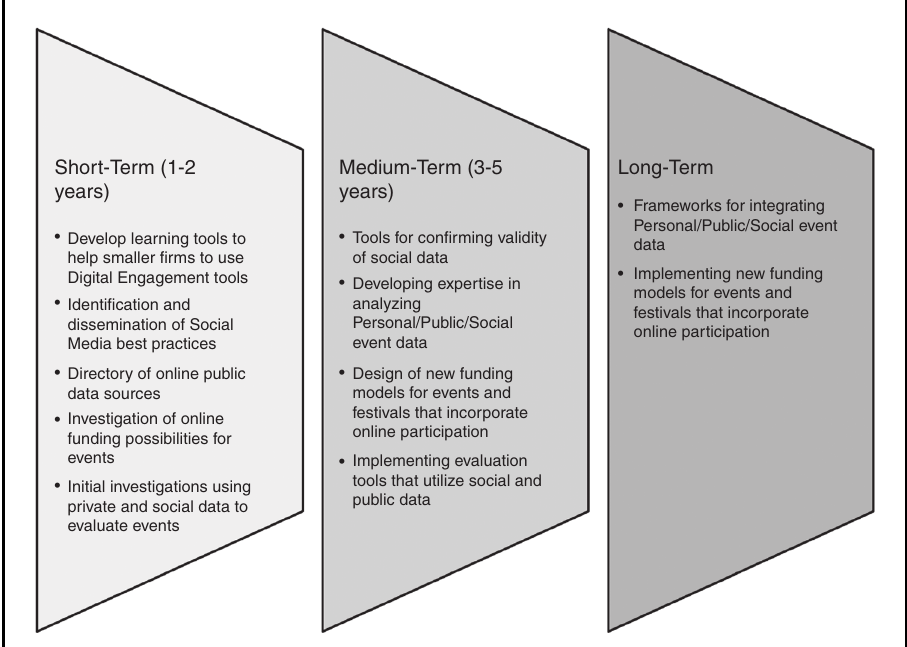
Figure 3 Road map for the future of festivals and digital